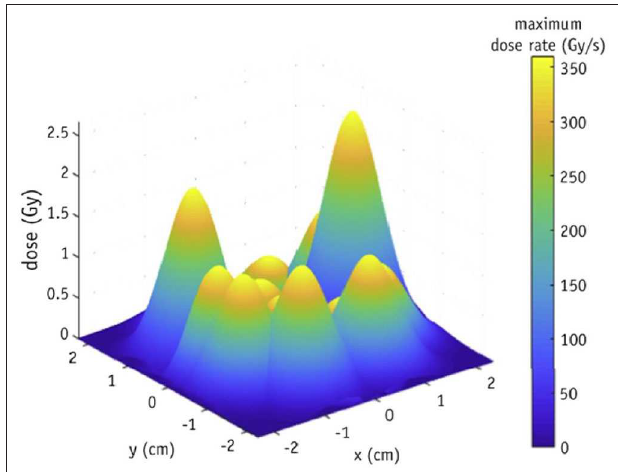
FIGURE 4 | Spatial distribution of dose-rate within a pencil beam scanned proton beam illustrating the role of scatter contribution from adjacent spots, which leads to an inhomogeneous distribution of dose-rate. A point detector or an imaging array with coarse detector spacing will be unable to measure dose-rate distribution with accuracy. Figure adapted from Marlen et al. [ 34]. Reprinted from “Bringing FLASH to the Clinic: Treatment Planning Considerations for Ultra high Dose-Rate Proton Beams”, Vol 106/Issue 3, Figure 2A , Copyright (2020), with permission from Elsevier.